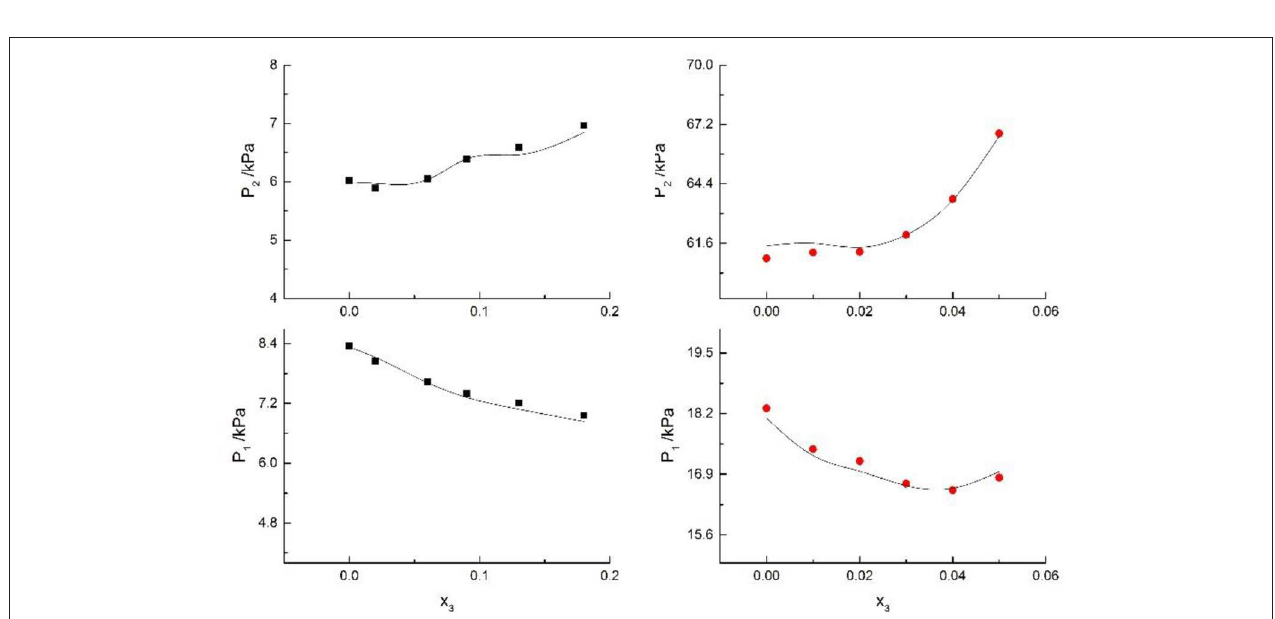
FIGURE 8 | Correlation of VLE data for H2O(1) + CH3OH(2) + KCl(3) system. Filled symbols ( (cid:4) x2 = 0.08 and T ≈ 316K; • x2 = 0.46 and T = 341K) indicate Literature data (Xu et al., 2018); curves indicate correlation of the